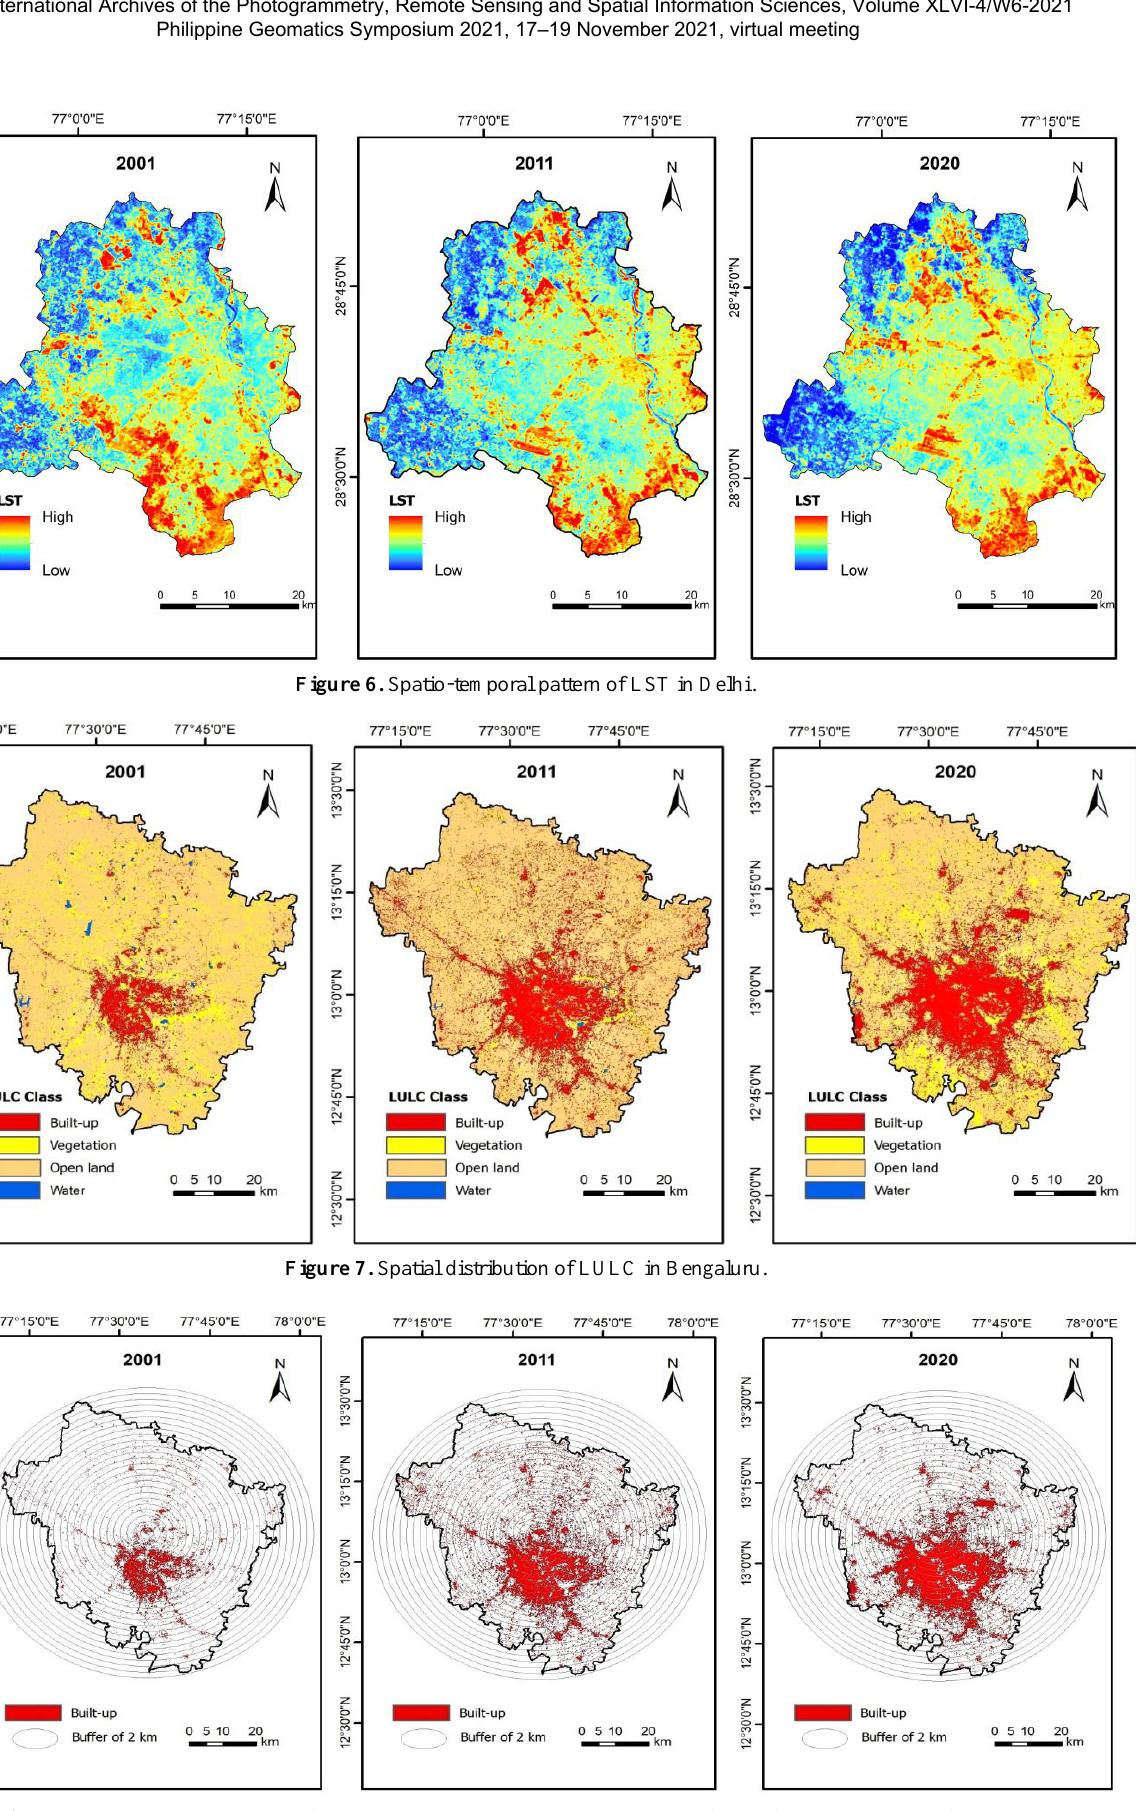
Figure 8. Zone-wise built-up area from 2001 to 2020 within a radial distance of 2 km from the centroid of